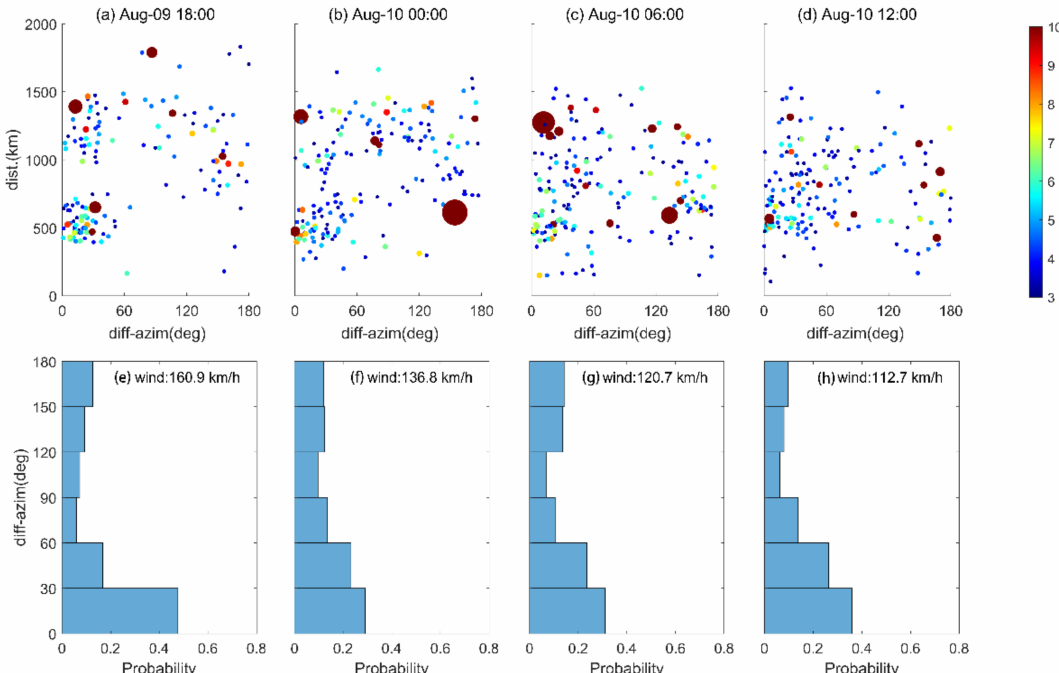
Figure 8. ( a – d ) Scatter of azimuth differences with distance between station and typhoon eye at UTC time 9 August 18:00, 10 August 00:00, 10 August 06:00 and 10 August 12:00, respectively; ( e – h ) probability histogram of azimuth differences at the four corresponding time epochs.